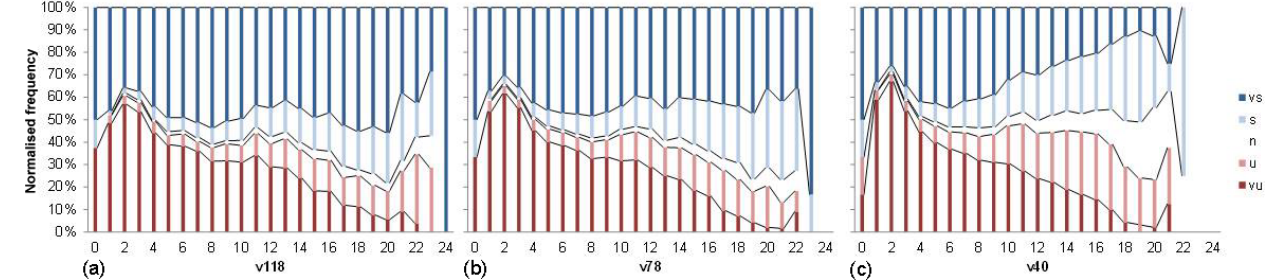
Figure 5. Distribution of atmospheric stability with wind speed based on z/L obtained with the sonic anemometer at different heights: 115.5m (a) , 75.5m (b) and 39.5m (c) . vs, very stable; s, stable; n, neutral; u, unstable; vu, very unstable.